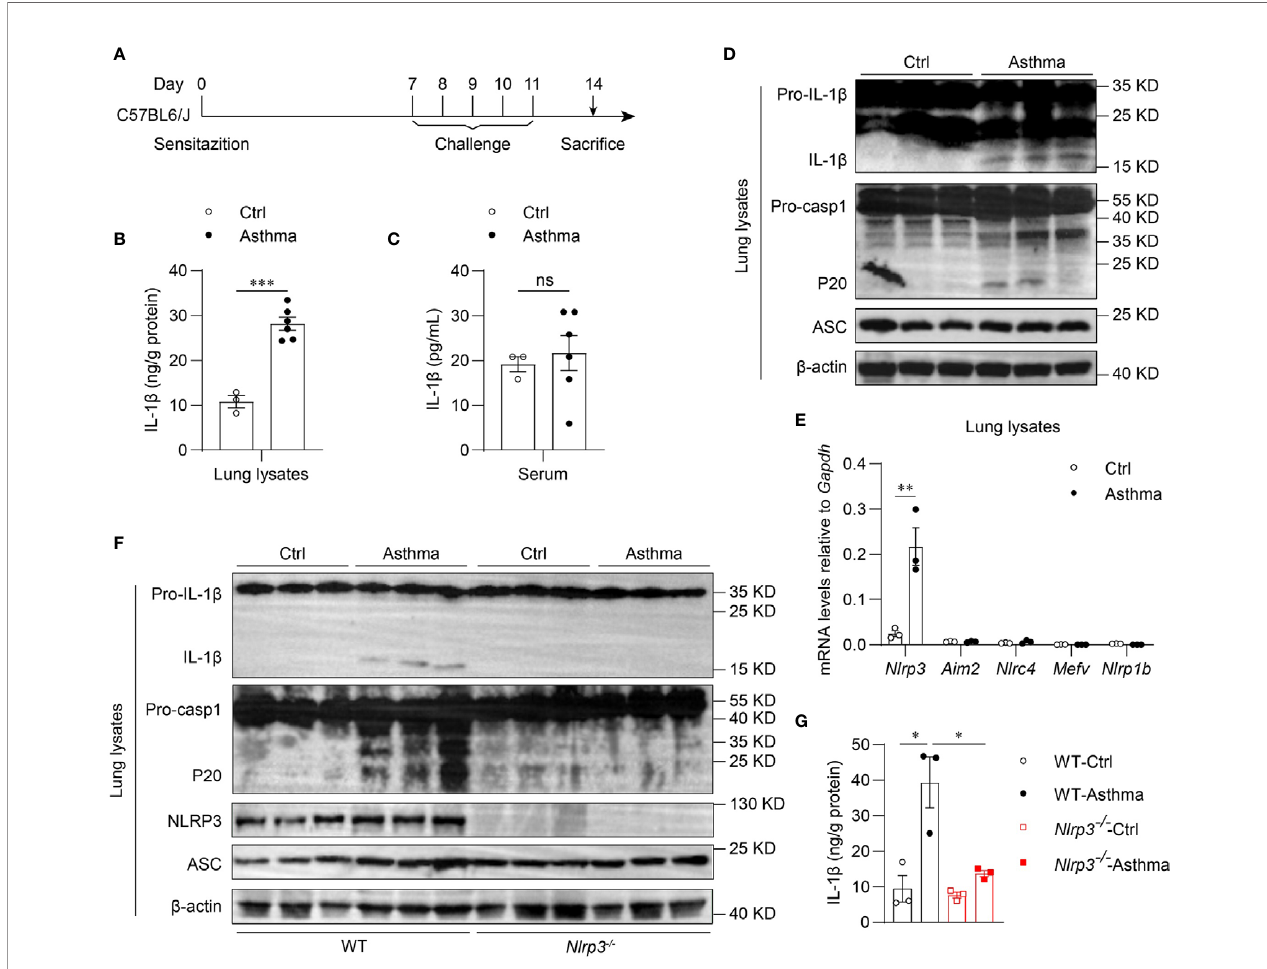
FIGURE 1 | Inhaled HDM induces NLRP3 in fl ammasome activation in allergic asthma. (A) Mice were sensitized and challenged with 10 m g HDM i.n. on day 0 and days 7-11. The mice in control group were sensitized and challenged by inhaling saline. On day 14, all mice were euthanized for analysis. (B – E) Wild type mice were stimulated with HDM or saline for 14 days. ELISA analysis of IL-1 b in lung lysates (B) and serum (C) ; n = 3-6 biologically independent mice. (D) Western blot analysis of IL-1 b , caspase-1 and ASC in lung lysates; n = 2 biologically independent experiments. (E) Nlrp3 , Aim2 , Nlrc4 , Mefv and Nlrp1b mRNA levels in the lungs were measured using qPCR; n = 3 biologically independent mice. (F, G) Wild type and Nlrp3 -/- mice were sensitized and challenged with HDM. Mice were euthanized on day 14 for analysis. (F) Western blot analysis of IL-1 b , caspase-1, ASC and NLRP3 in lung lysates; n = 2 biologically independent experiments. (G) ELISA analysis of IL-1 b in WT and Nlrp3 -/- mice lung lysates; n = 3 biologically independent mice. Statistical signi fi cances were analyzed by unpaired Student ’ s t -test: * P < 0.05, ** P < 0.01, *** P < 0.001 , ns (not signi fi